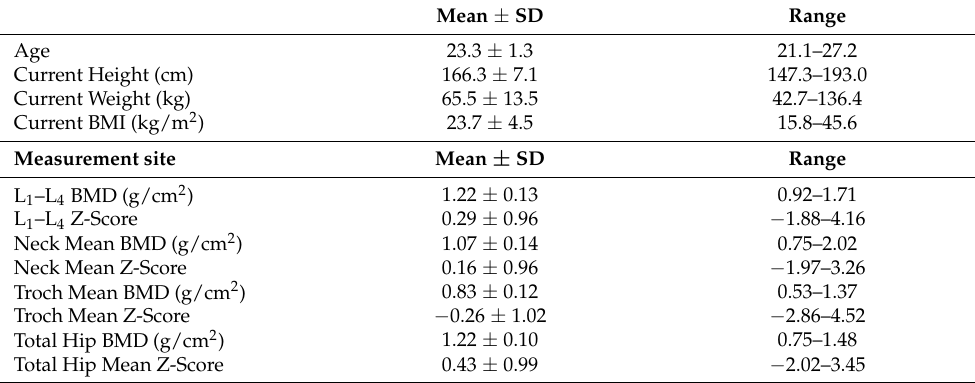
Table 1. Descriptive characteristics (age, height, weight, BMI, and BMD measured in (g/cm 2 ) and BMD z-scores of study population. (N =